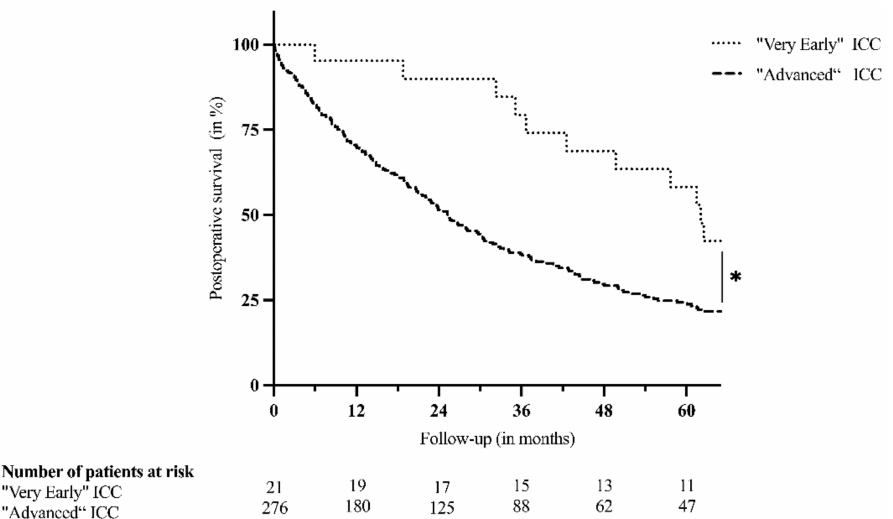
Figure 1. Postoperative survival after resection of “very early” (single tumor ≤ 3 cm) and “advanced” (>3 cm, multifocality or extrahepatic disease) intrahepatic cholangiocarcinoma (ICC). * p -value: